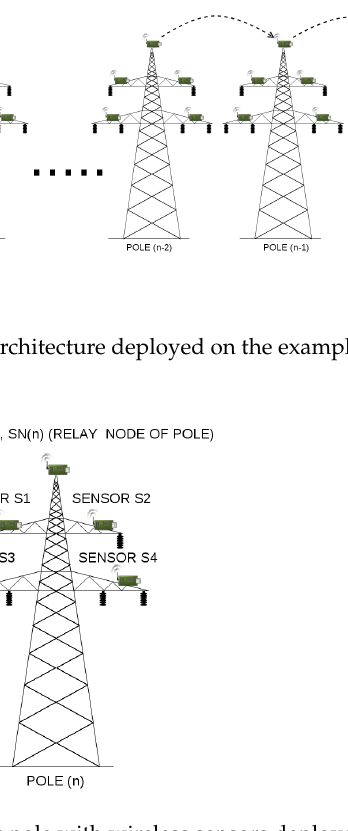
Figure 4. An electric pole with wireless sensors deployed.